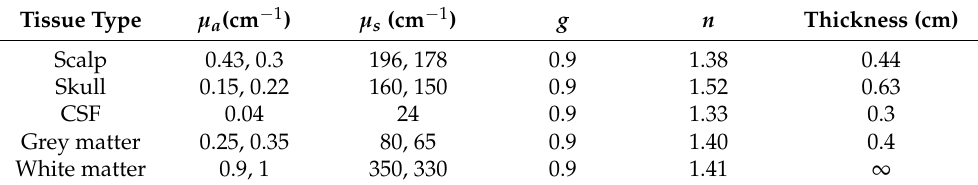
Figure 5. Planar model of a human head used in MC simulations with a schematically placed photodetector and a light source. Table 2. Optical properties of the tissues of a human head at 800 nm and 940 nm (separated by comma) and thicknesses of tissue layers in the planar model of a human head (last column) [46–54].